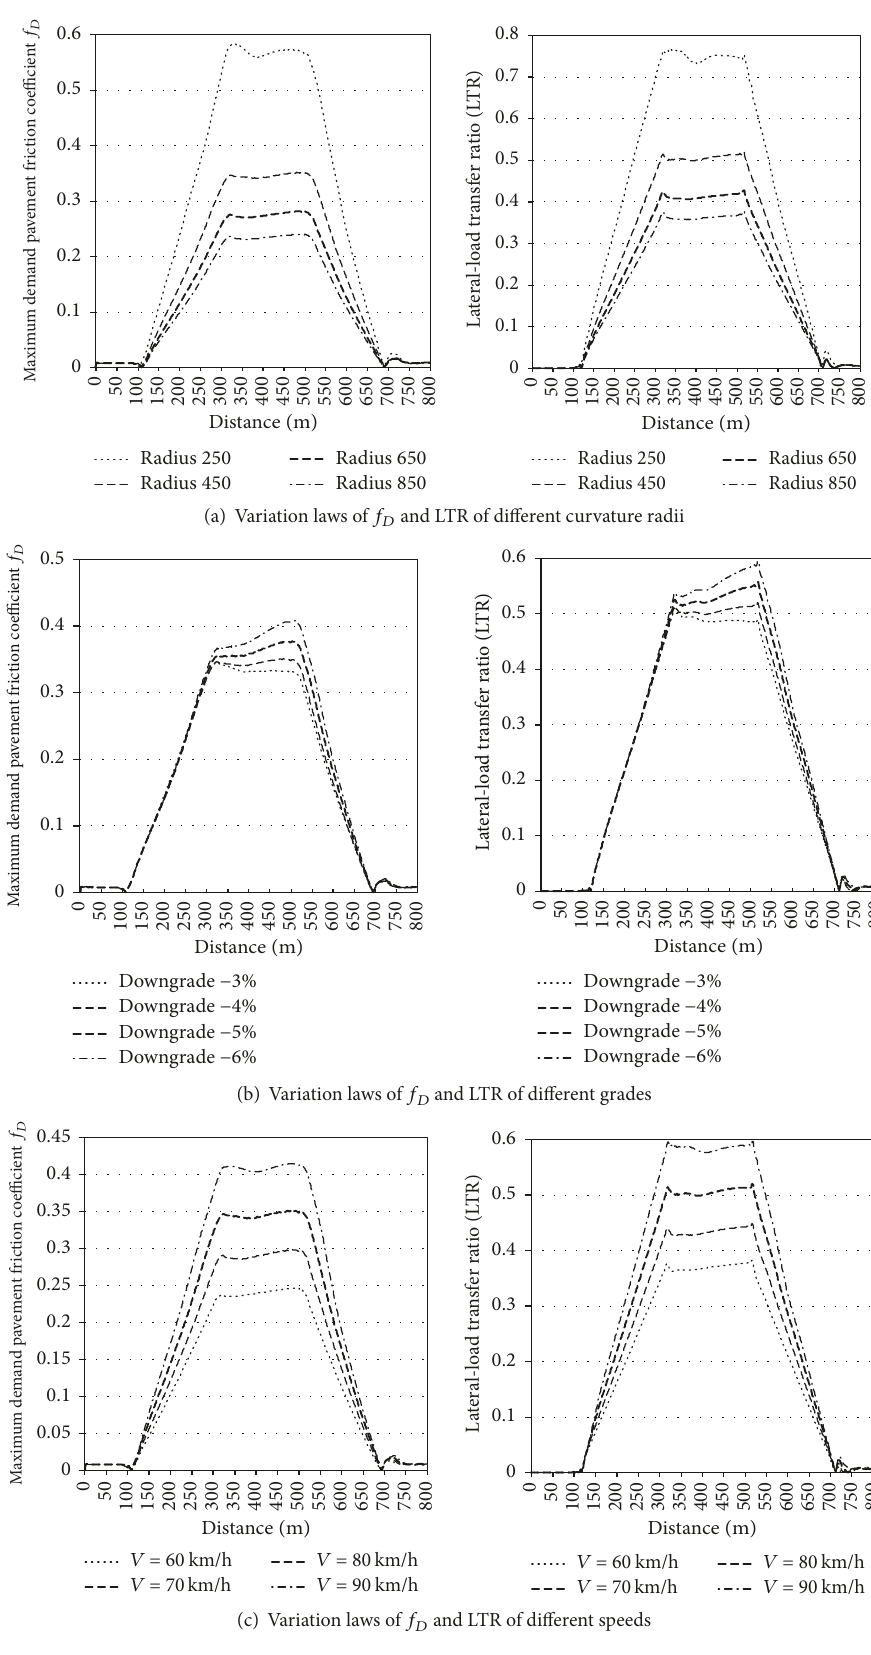
Figure 8: Variation laws of 𝑓 𝐷 and LTR on curved